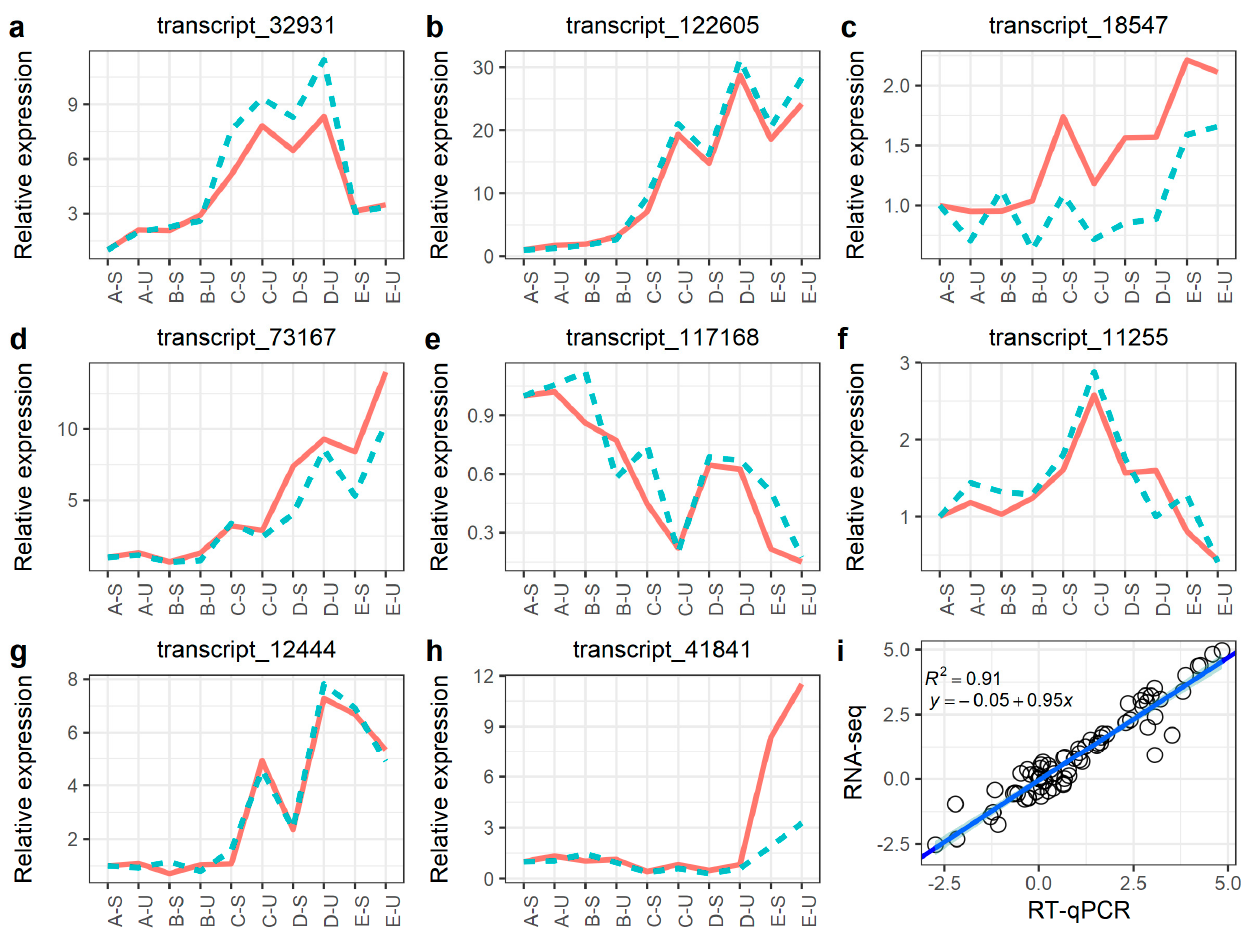
Figure 5. Correlation between the RT-qPCR and RNA-Seq data. ( a – h ): Relative expression of screened genes in transcriptome and RT-qPCR; ( i ): Correlation between the relative expression of transcriptome and RT-qPCR. Note: in ( a – h ), the blue line represented RT-qPCR, the red line represented RNA-seq.